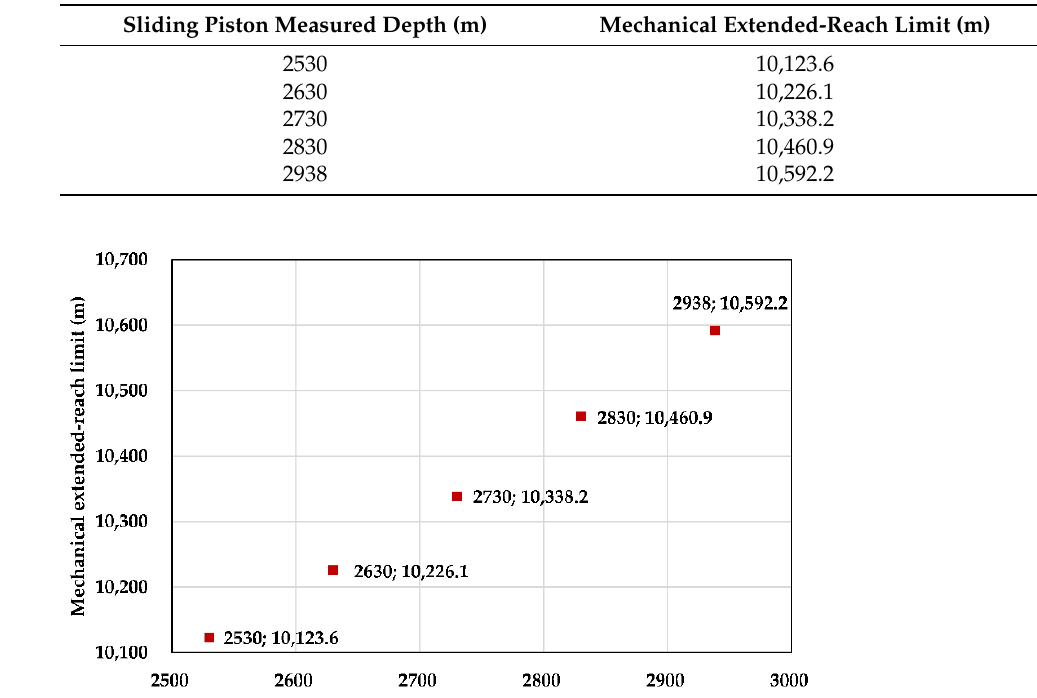
Table 6. Mechanical extended-reach limits with different sliding piston measured depths.